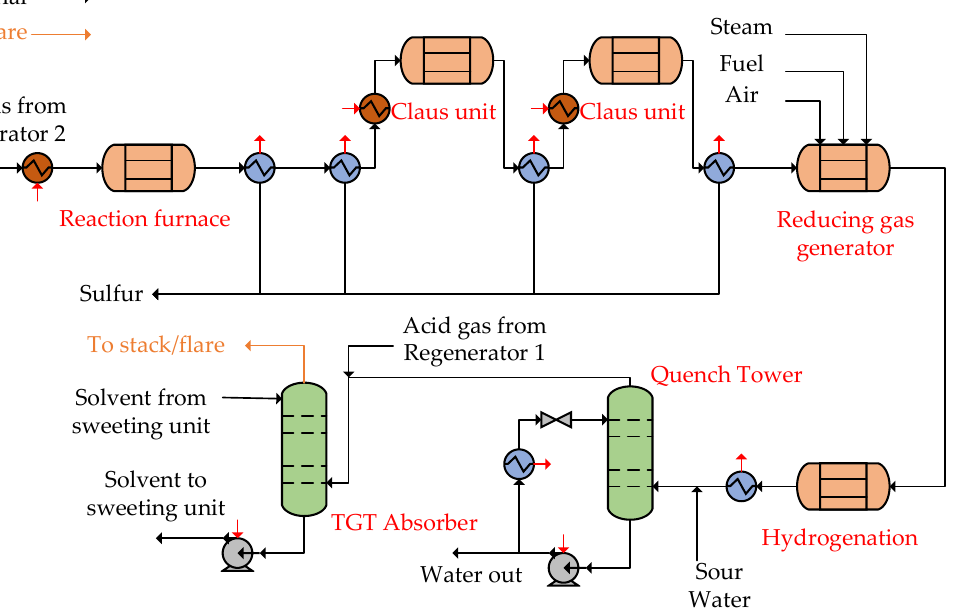
Figure 5. PFD of the simulated sweetening unit.